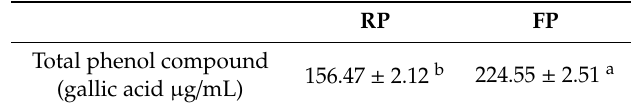
Table 1. The amounts of total phenol compound in pepper extract, both before and after fermentation (gallic acid µ g / mL).